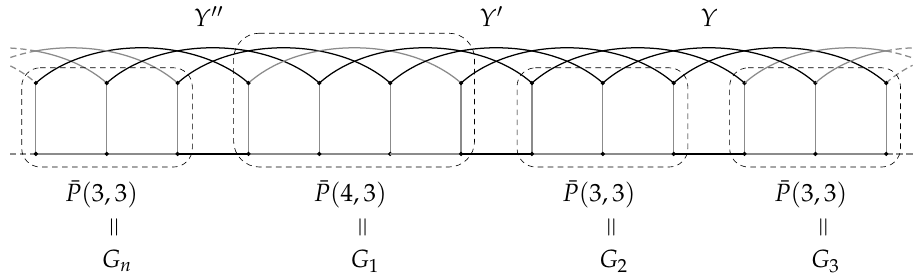
Figure 5. P ( 3 n + m ,3 ) as nearly rotagraph for m = 1. Graphs for m = 2 are obtained